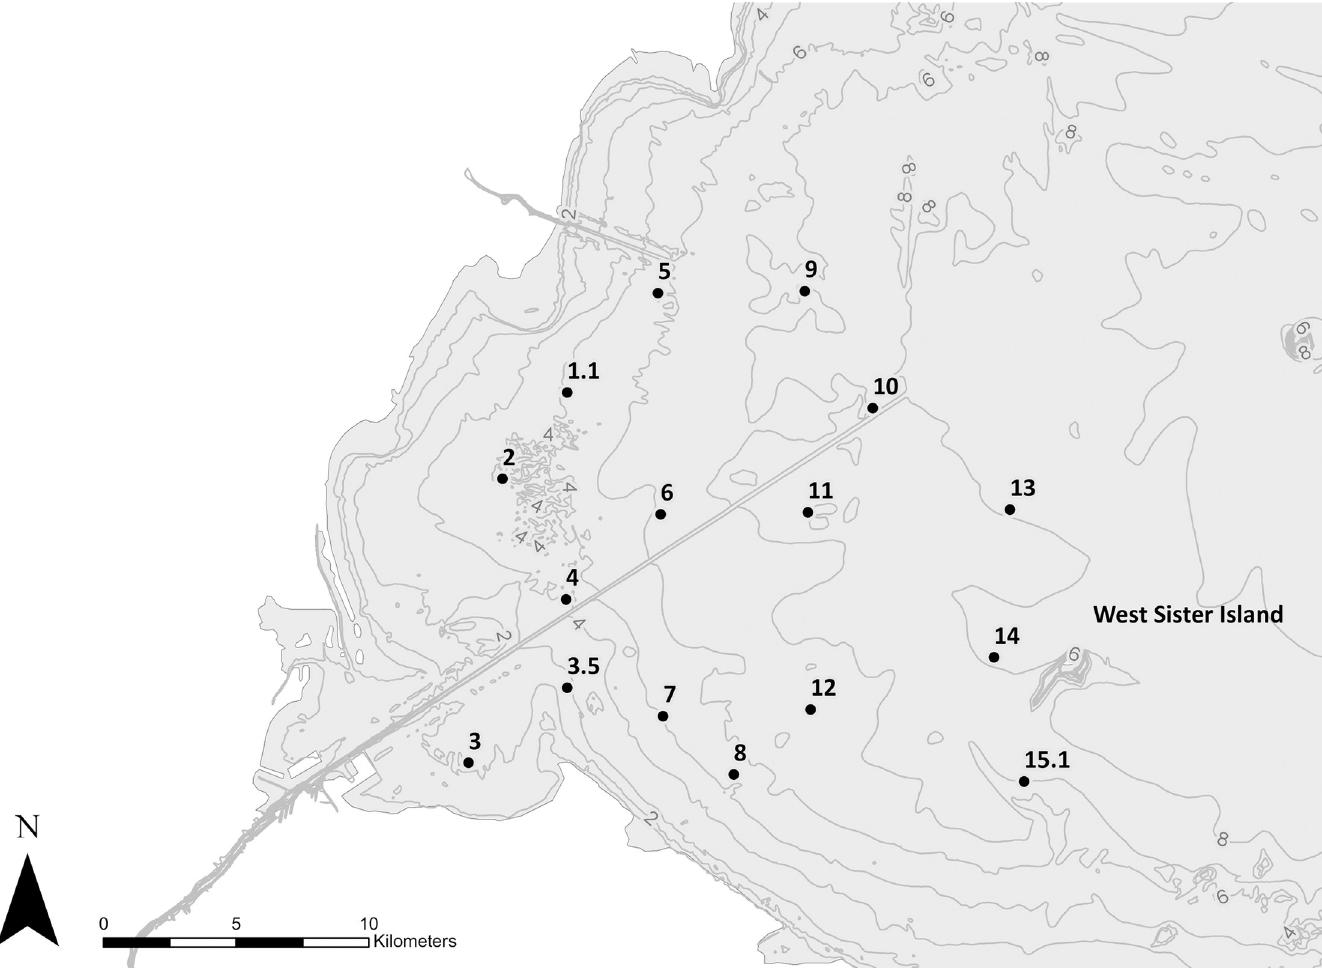
Fig 1. Sixteen sites were selected for sampling over a two-year period corresponding to the region within western Lake Erie where HABs are most prevalent and persistent. Bathymetry of Lake Erie (in meters) obtained from the National Geophysical Data Center, NOAA.